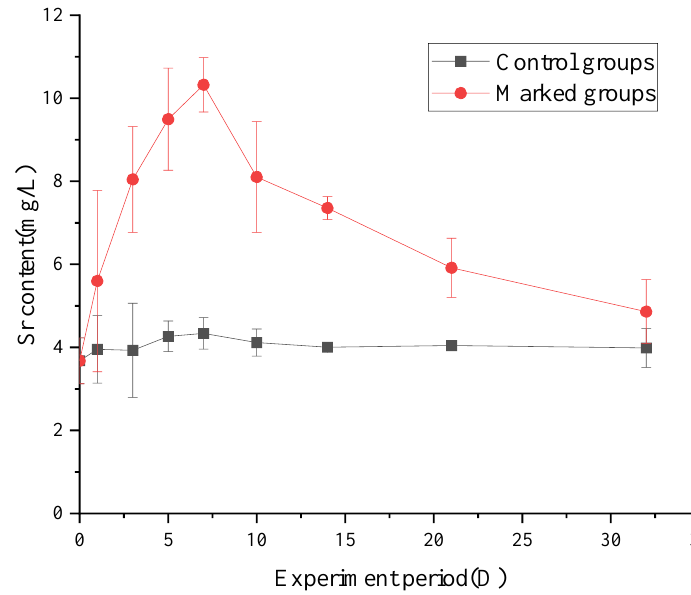
Figure 4. The variation trend of Sr 2+ in gill of T. obscurus .